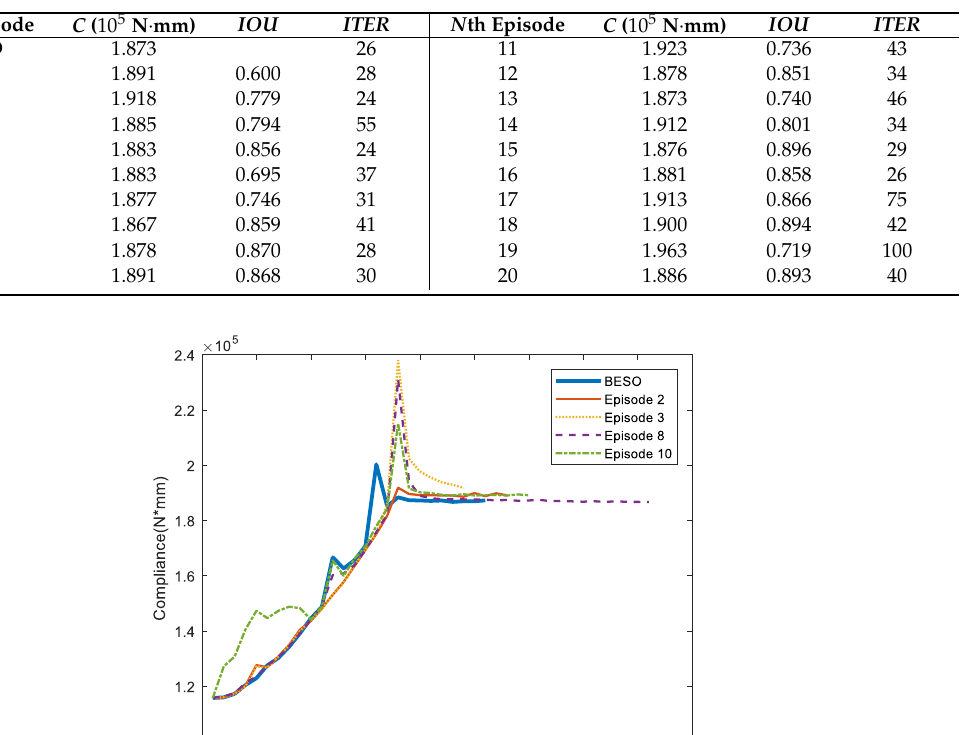
Table 1. Calculation results of the cantilever beam by UCB with BESO.